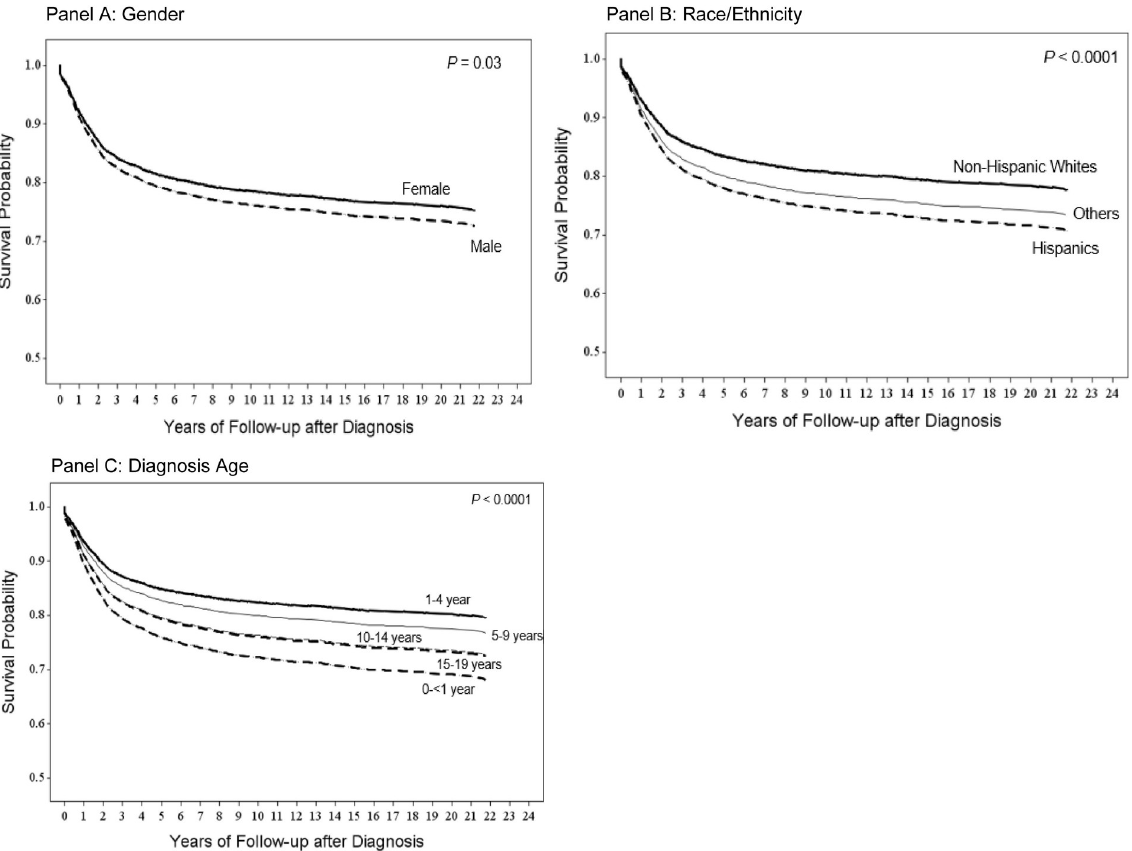
Fig 1. South Texas childhood cancer multivariable-adjusted Kaplan-Meier survival curves by gender, race/ethnicity, and diagnosis age. (A) Survival curves stratified by gender with the adjustment of race/ethnicity (2 groups: Hispanic and non-Hispanic whites) and diagnosis age (5 groups: < 1 year, 1–4 years, 5–9 years, 10–14 years, and 15–19 years). (B) Survival curves in different races/ethnicities with the adjustment of gender (2 groups: male and female) and diagnosis age (5 groups: < 1 year, 1–4 years, 5–9 years, 10–14 years, and 15–19 years). (C) Survival curves in different diagnosis age groups with the adjustment of gender (2 groups: Hispanic and non-Hispanic whites) and race/ethnicity (2 groups: Hispanic and non-Hispanic whites).